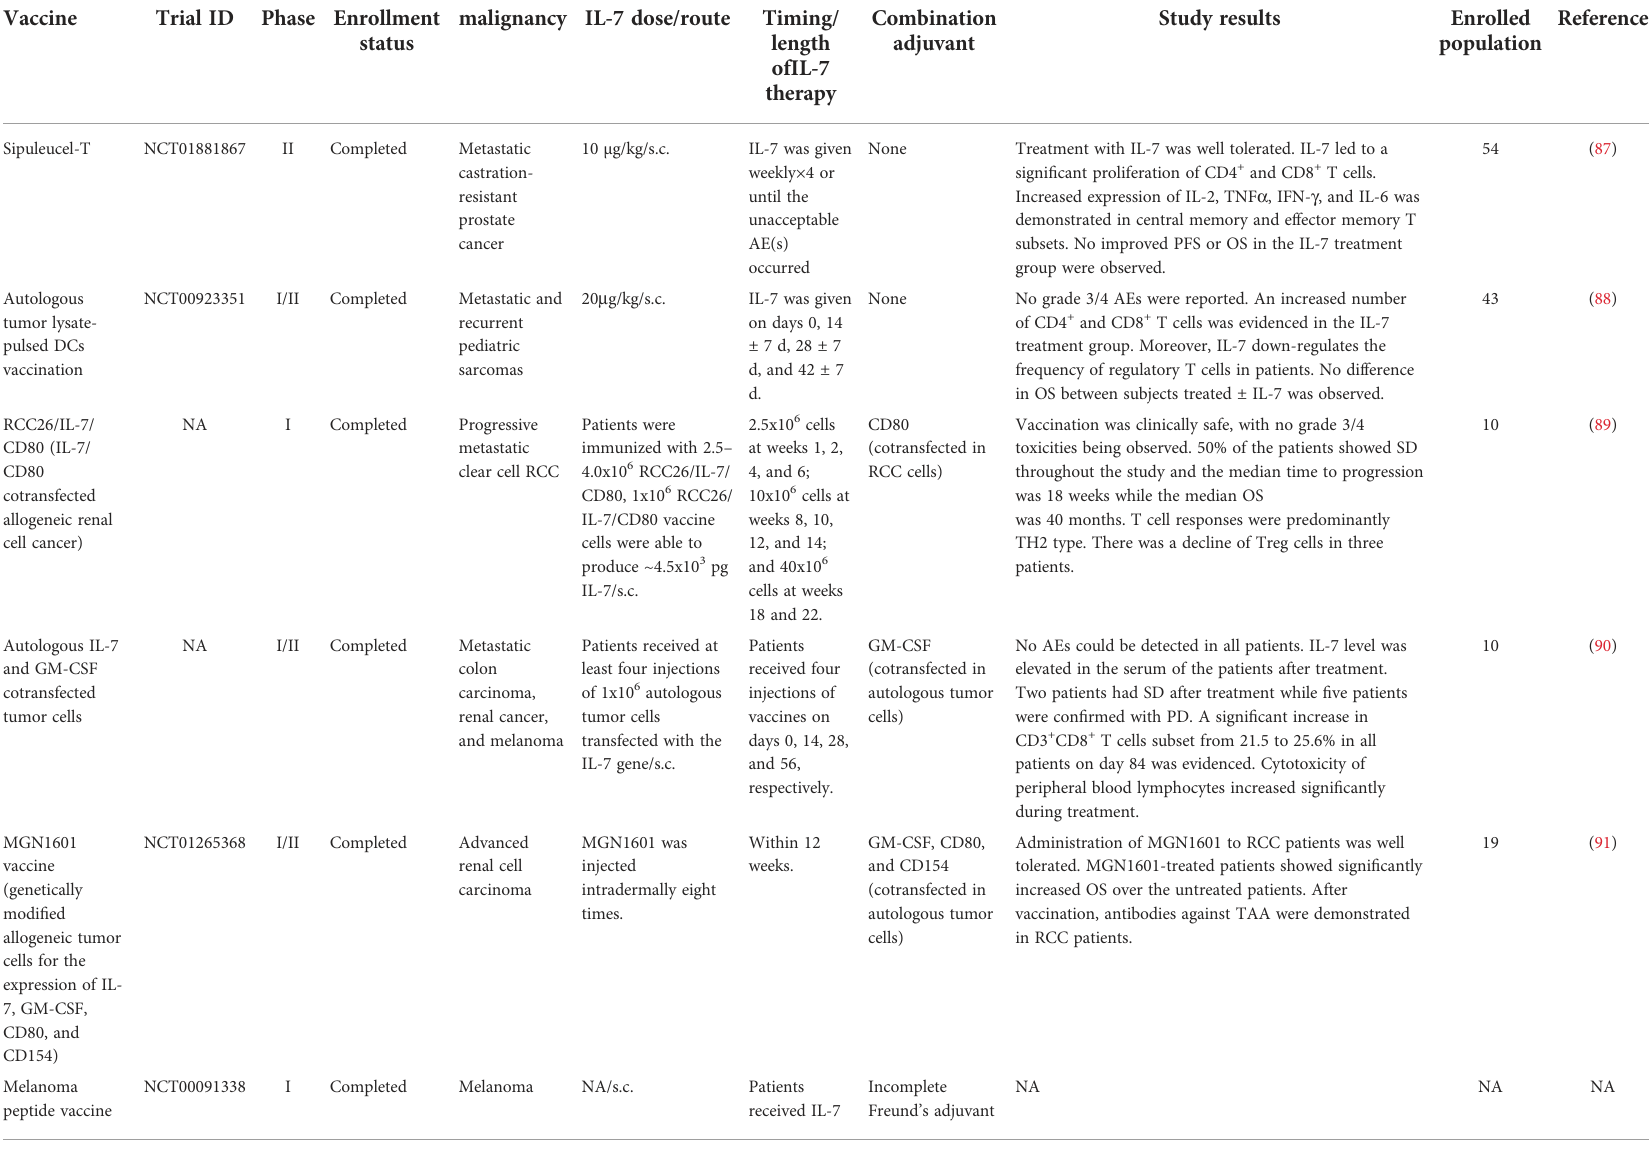
TABLE 2 Clinical trials of cancer vaccines combined with IL-7 as an adjuvant for the treatment of